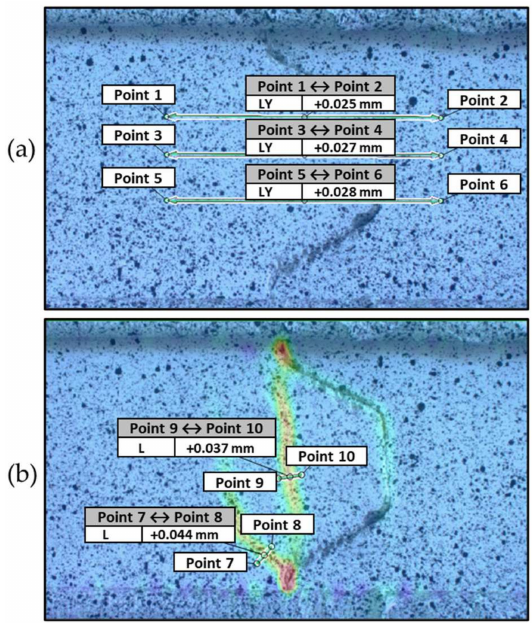
Figure 12. Application of the GOM Correlate: ( a ) analysis of the vertical displacement of the specimen and ( b ) analysis of the crack opening in the shear